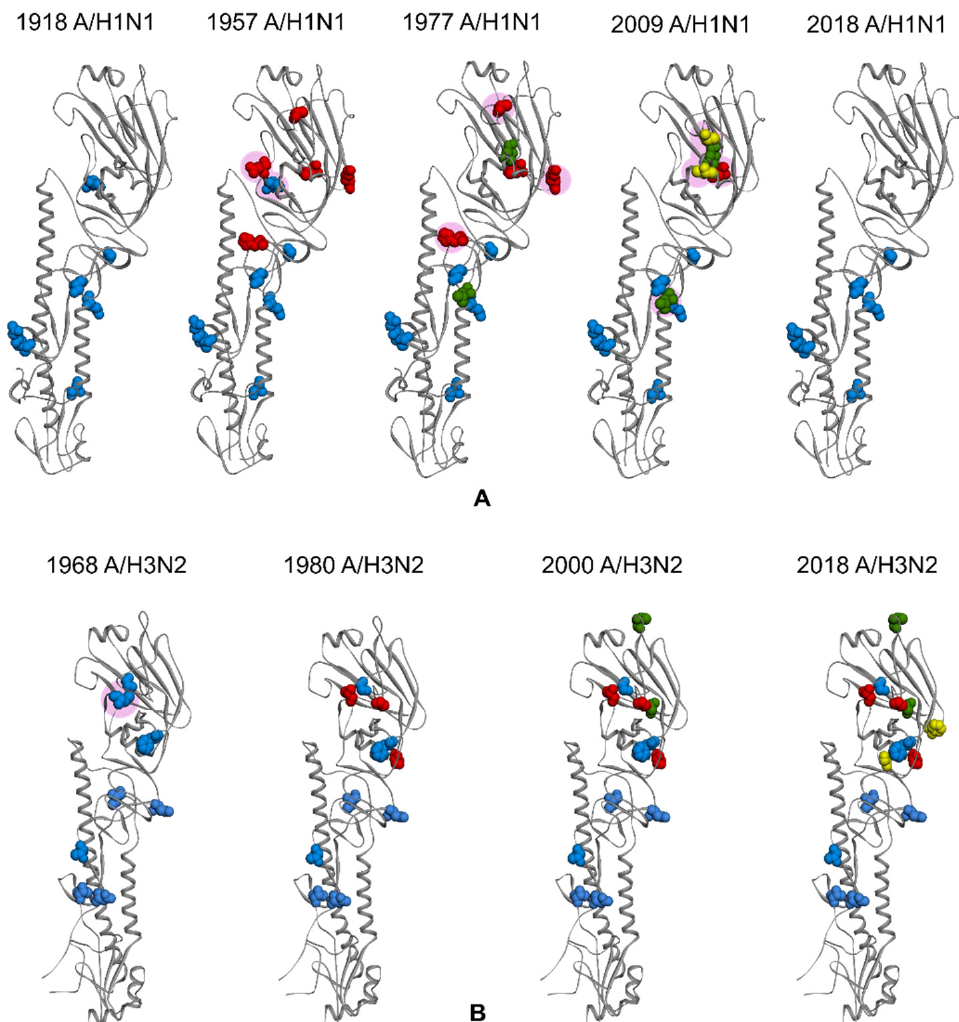
Figure 4. Some of the NLG sites of 1918 HA ( A ) and 1968 HA ( B ). Blue color residues represented the NLG sites when they were first identified, while red, green, and yellow color residues represent NLG sites acquired afterward. The pink circle represents the NLG sites that have been lost during the evolution. The 1918 A/H1N1 initially possessed six NLG sites and acquired five more in 1957. The 1977 A/H1N1 gained two NLG sites but lost two, whereas 2009 A/H1N1 gained two sites and lost three. The current 2018 A/H1N1 circulating strain has lost five more NLG sites compared to the 2009 strain. Meanwhile, NLG sites in 1968 A/H3N2 HA globular head have been gradually increasing from initially two in 1968 to eight in the current 2018 strain (with the loss of site 97 in